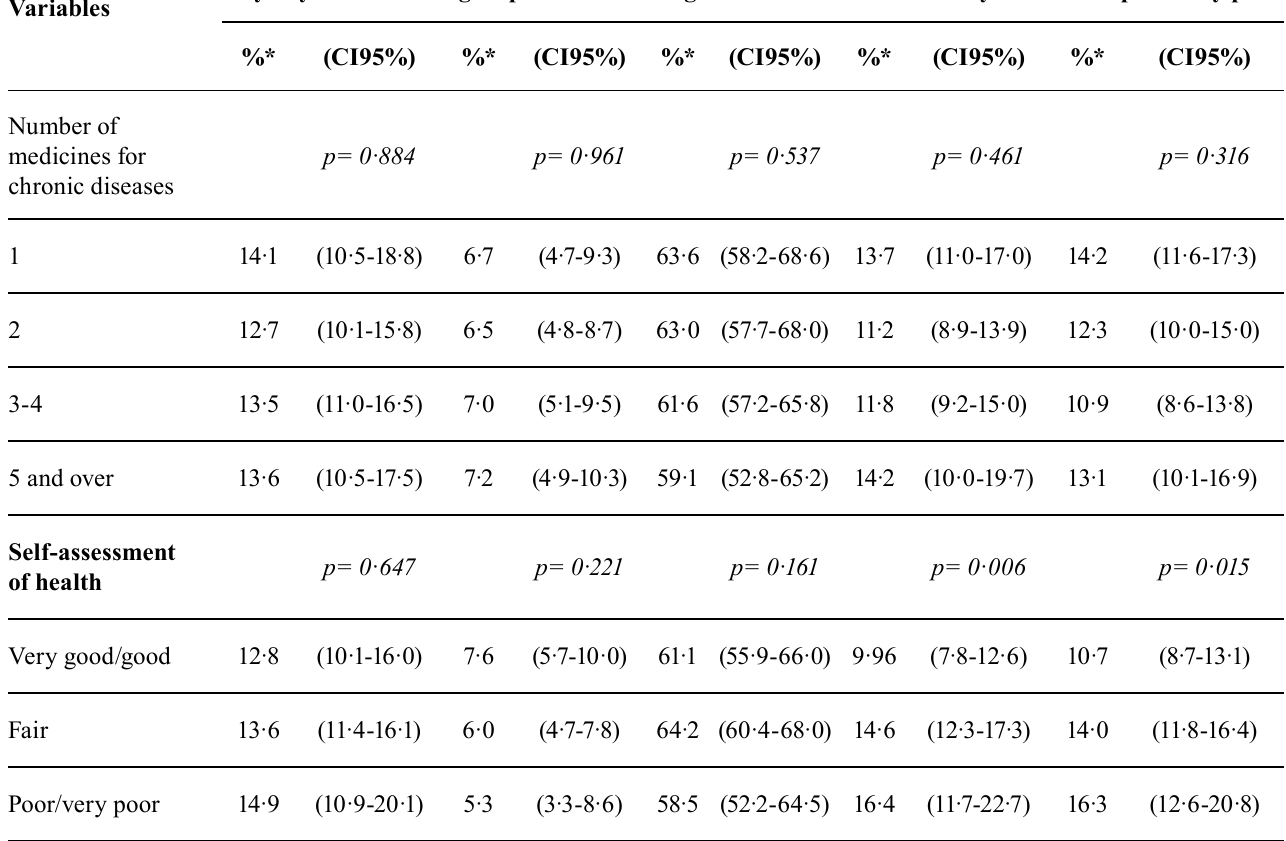
TABLE IV – Difficulties related to the acceptability of SUS pharmacy services by adult and elderly (20 years and over) users of the Unified Health System (SUS) with a reported chronic noncommunicable disease (NCD), indication of medicine treatment and that obtain some of the medicines in use in the SUS, according to demographic, socioeconomic and health variables PNAUM, 2014